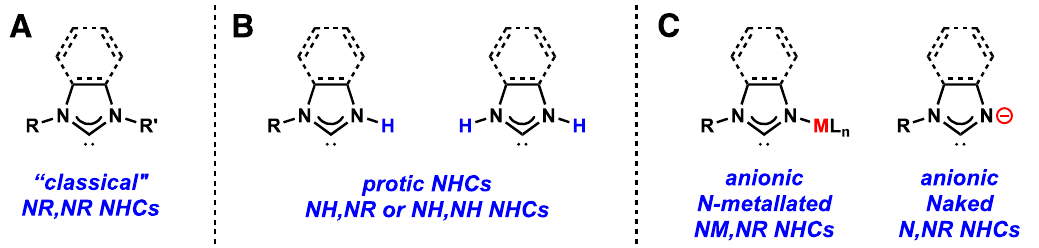
Figure 1. Substitution patterns of N -heterocyclic carbene (NHC) nitrogen atoms delineating: ( A ) “classical” NR,NR NHCs, ( B ) protic NH,NR or NH,NH NHCs, ( C ) and anionic NM,NR or naked N,NR NHCs.